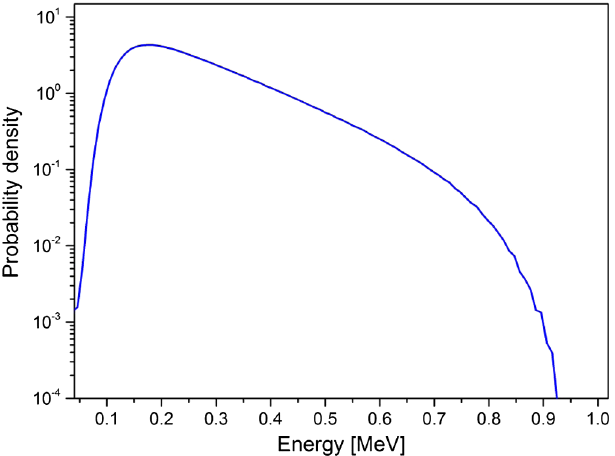
FIG. 15. Time integrated photon energy distribution function behind the conversion